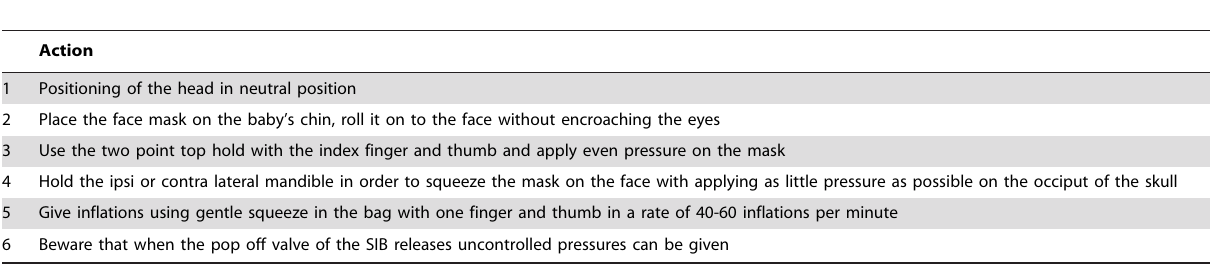
Table 1. Key-points discussed during face mask training using the self-inflating bag.